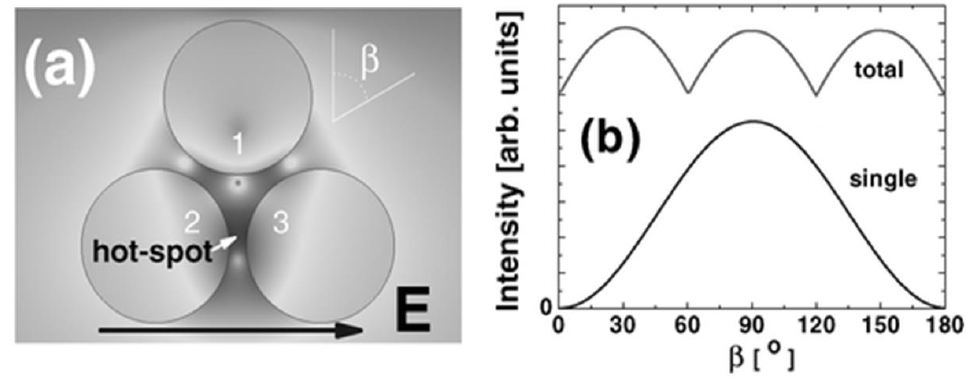
Figure 12. A simple example of a cluster with quasi-isotropy. In this case an example of a 2D cluster formed by three cylinders (radii = 25 nm) with a small separation gap ( 𝑑 = 6.7 nm) is shown. The problem is solved in the electrostatic approximation, wavelength = 357 nm. The polarization is changed in the plane for different angles 𝛽 as shown in ( a ) where the electromagnetic intensity (on a logarithmic grey-scale) is explicitly shown for the case 𝛽 = 90° . A hot-spot in between cylinders 2 and 3 can be easily seen. If we look at the maximum enhancement at any point on the surface of the cluster, there will always be a place that profits the most from the particular orientation of the field and we obtain the curve labelled as ‘‘total’’ in ( b ). The three maxima in the latter are the three possible two-cylinder hot-spots in this cluster that achieve their highest value when the field is aligned along the axis joining any two of them. If the surfaces were uniformly covered with analyte, an almost isotropic response is obtained. The degree of isotropy increases with the complexity of the cluster. However, if the enhancement at one specific point is monitored (in this case the enhancement in the gap in between 2 and 3) we obtain the curve labelled as ‘‘single’’ in ( b ) which shows the full anisotropy of any single hot-spot. Adapted from [40] with permission from The Royal Society of Chemistry.